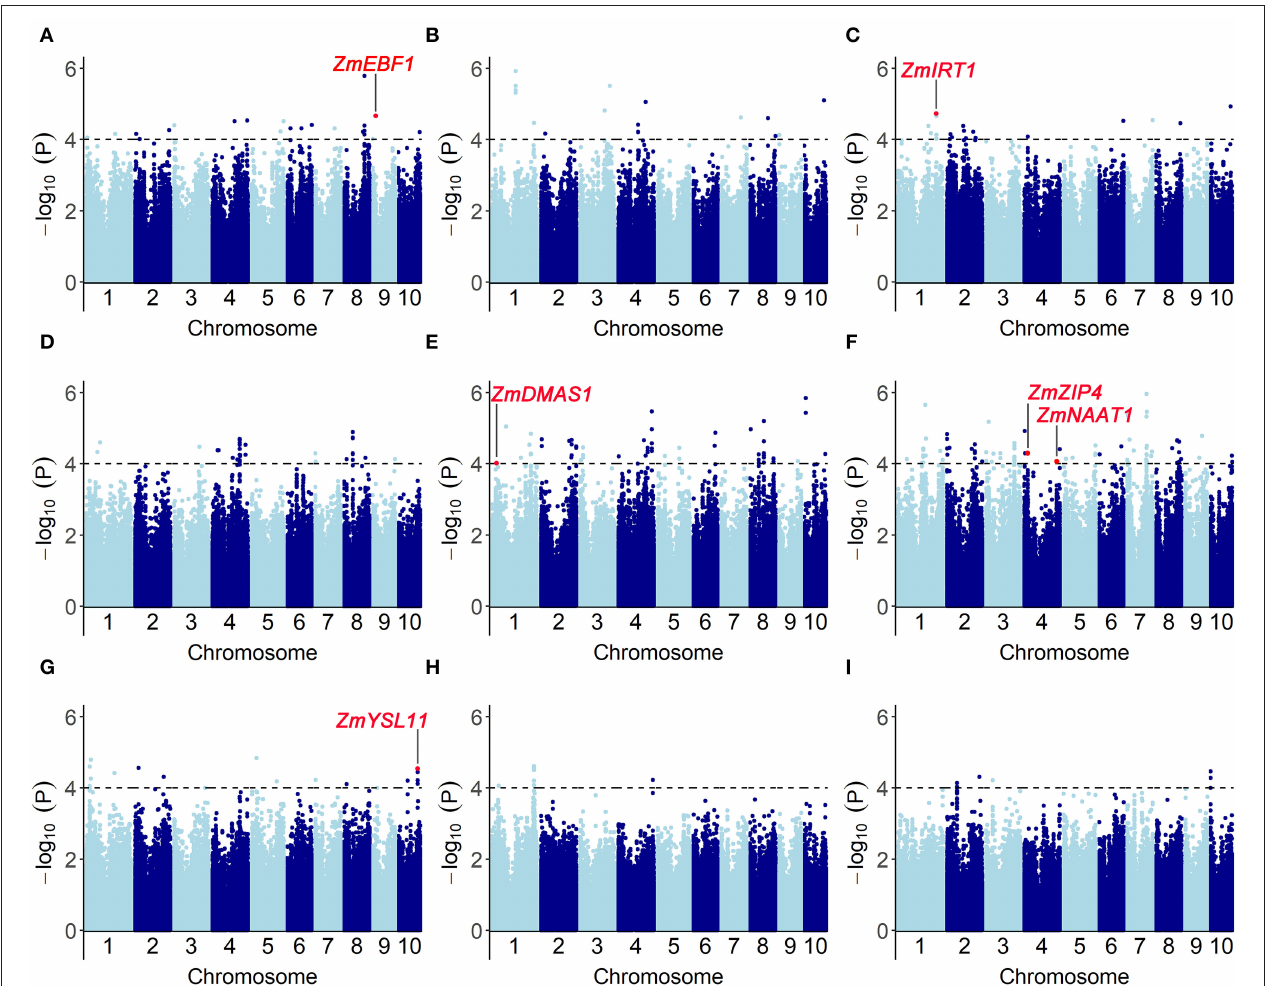
FIGURE 5 | Genome-wide association results for the traits associated with Fe-deficiency tolerance in a maize association population under different conditions (-Fe, -Fe/CK). Manhattan plots for (A) Fe score (FeSc), (B) plant height (PH), (C) root length (RL), [-Fe: (D) ; -Fe/CK: (G) ] shoot dry weight (SDW), [-Fe: (E) ; -Fe/CK: (H) ] root dry weight (RDW), [-Fe: (F) ; -Fe/CK: (I) ] R/S are shown. A total of 353 significant SNPs were identified at a significant level of P < 1 × 10 − 4 . Gray dashed lines correspond to the thresholds of P < 1 × 10 − 4 . Red dots refer to the significant SNPs that contain the genes associated with Fe-deficiency tolerance, including